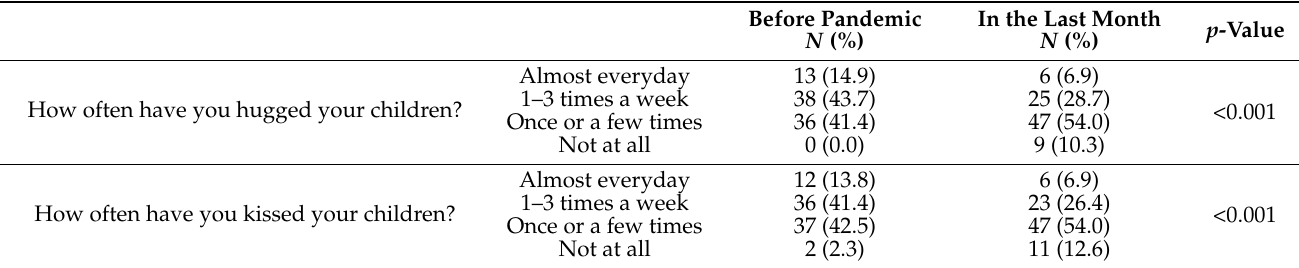
Table 2. Frequency of reporting physical positive touch before the COVID-19 Pandemic and in the last month with non-cohabiting